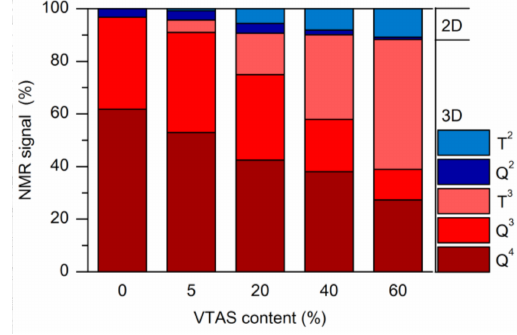
Figure 9. 3D and 2D evolution of the silica network with the vinyl